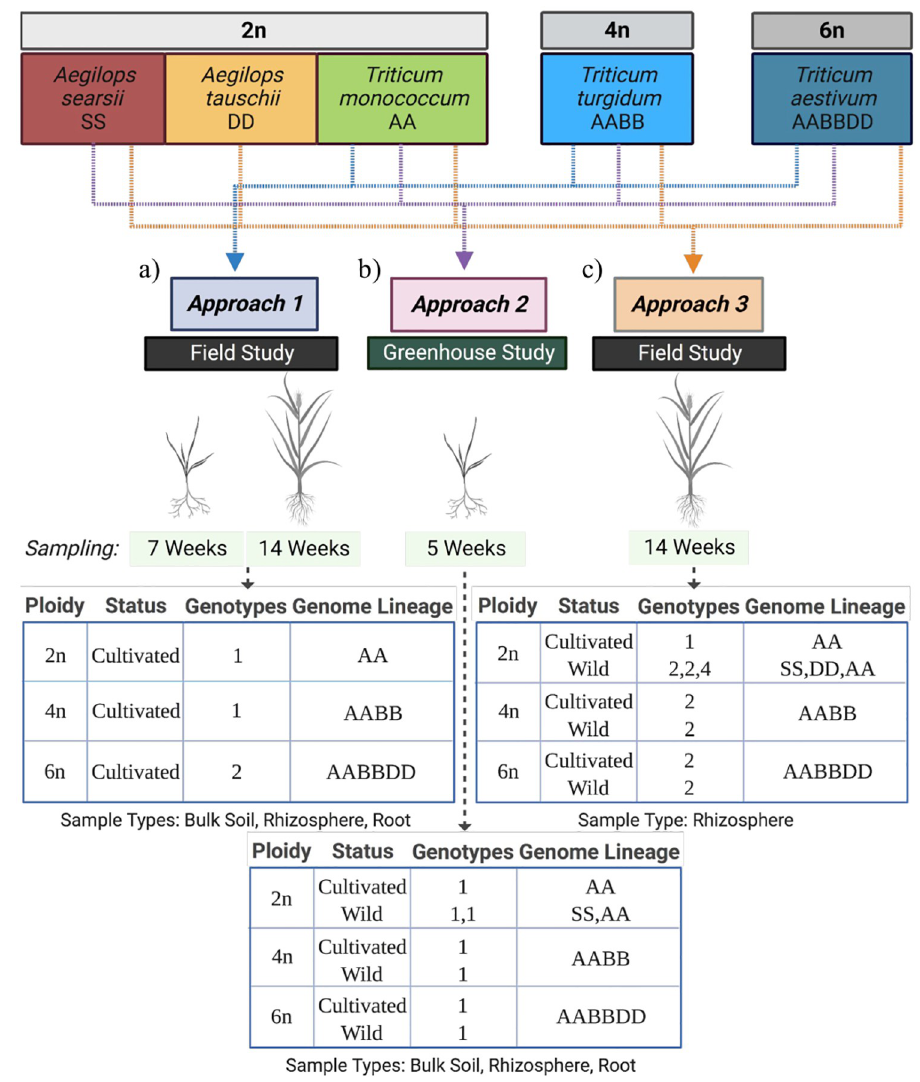
Fig 1. Overview of experimental approaches. Approach 1 (a), an analysis of data from Naylor er al. 2017 [42] with 3 replicates of 4 genotypes ( Triticum monococcum , 2n; T . turgidum , 4n; 2 varieties T . aestivum , 6n) grown in the field, in the summer of 2015, sampled at 7 weeks old and 14 weeks. Approach 2 (b), a greenhouse study in which 13 genotypes were sampled at 5 weeks old (wild Aegilops searsii (2n), wild and cultivated Gossypium hirsutum (4n) and wild G . arboreum (2n), and a cultivated and wild line of: T . monococcum and Hordeum vulgare (2n), T . turgidum (4n), and T . aestivum (6n)). Approach 3 (c), a field study conducted in the summer of 2017 in which 27 genotypes were sampled at 14 weeks old (2 wild lines of A . searsii and T . tauschii (2n), wild and cultivated Gossypium hirsutum (4n) and wild G . arboretum and G . raimondii (2n) two cultivated and one wild line of: Hordeum vulgare (2n), T . monocuccum and T . urartu (2n), 2 cultivated and 2 wild lines of both T . turgidum (4n) and T . aestivum ). For both approaches 2 and 3, 4 replicates per species were sampled. Figure created with BioRender.com.